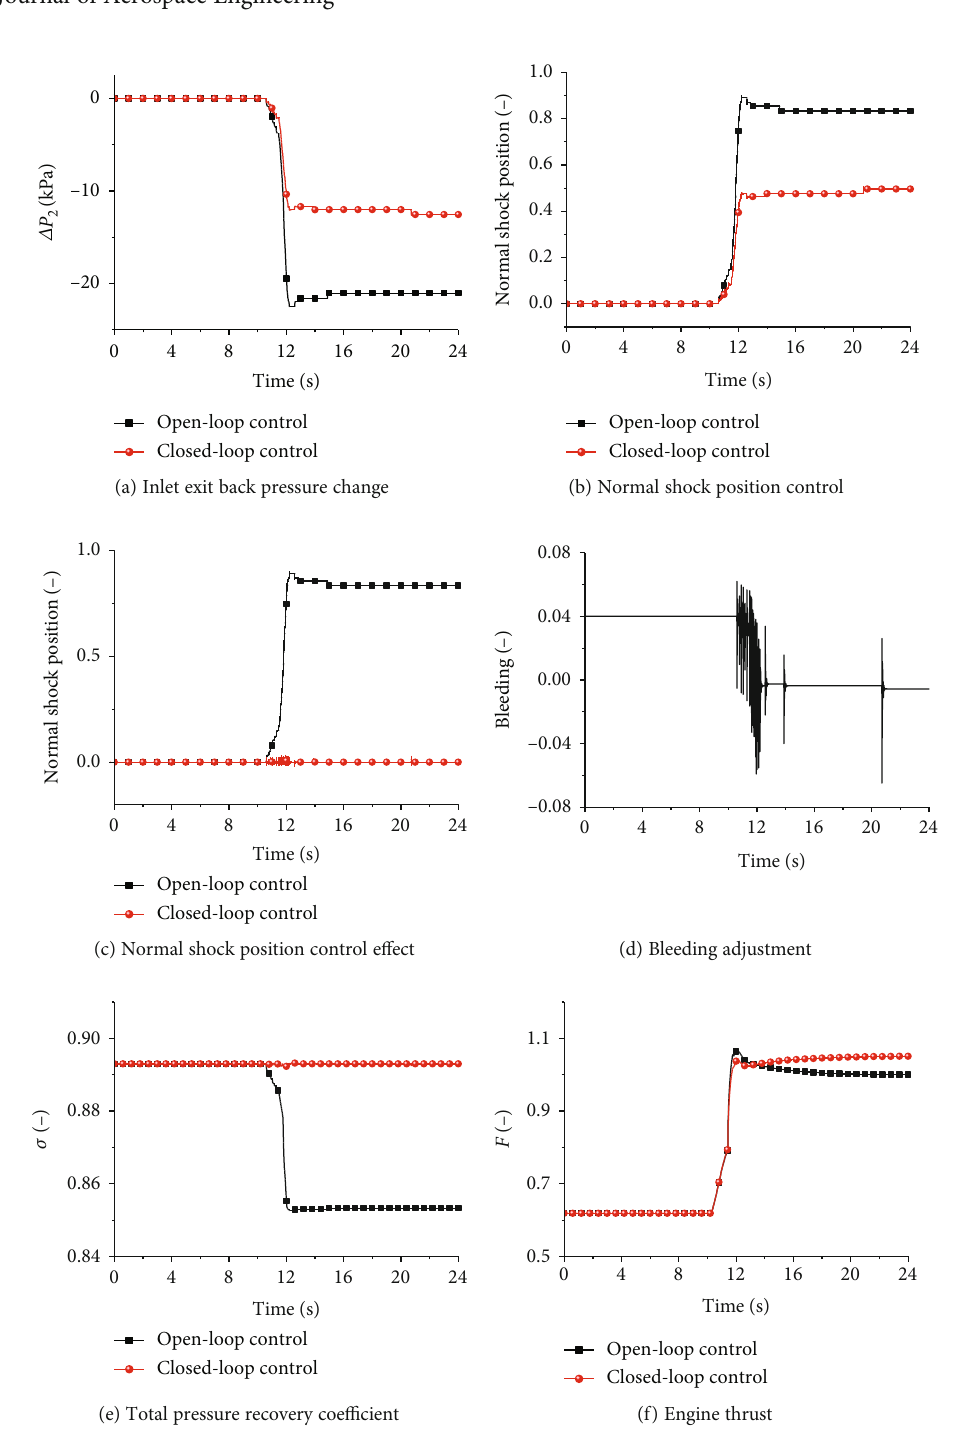
Figure 15: Simulation results of an integrated model under downstream